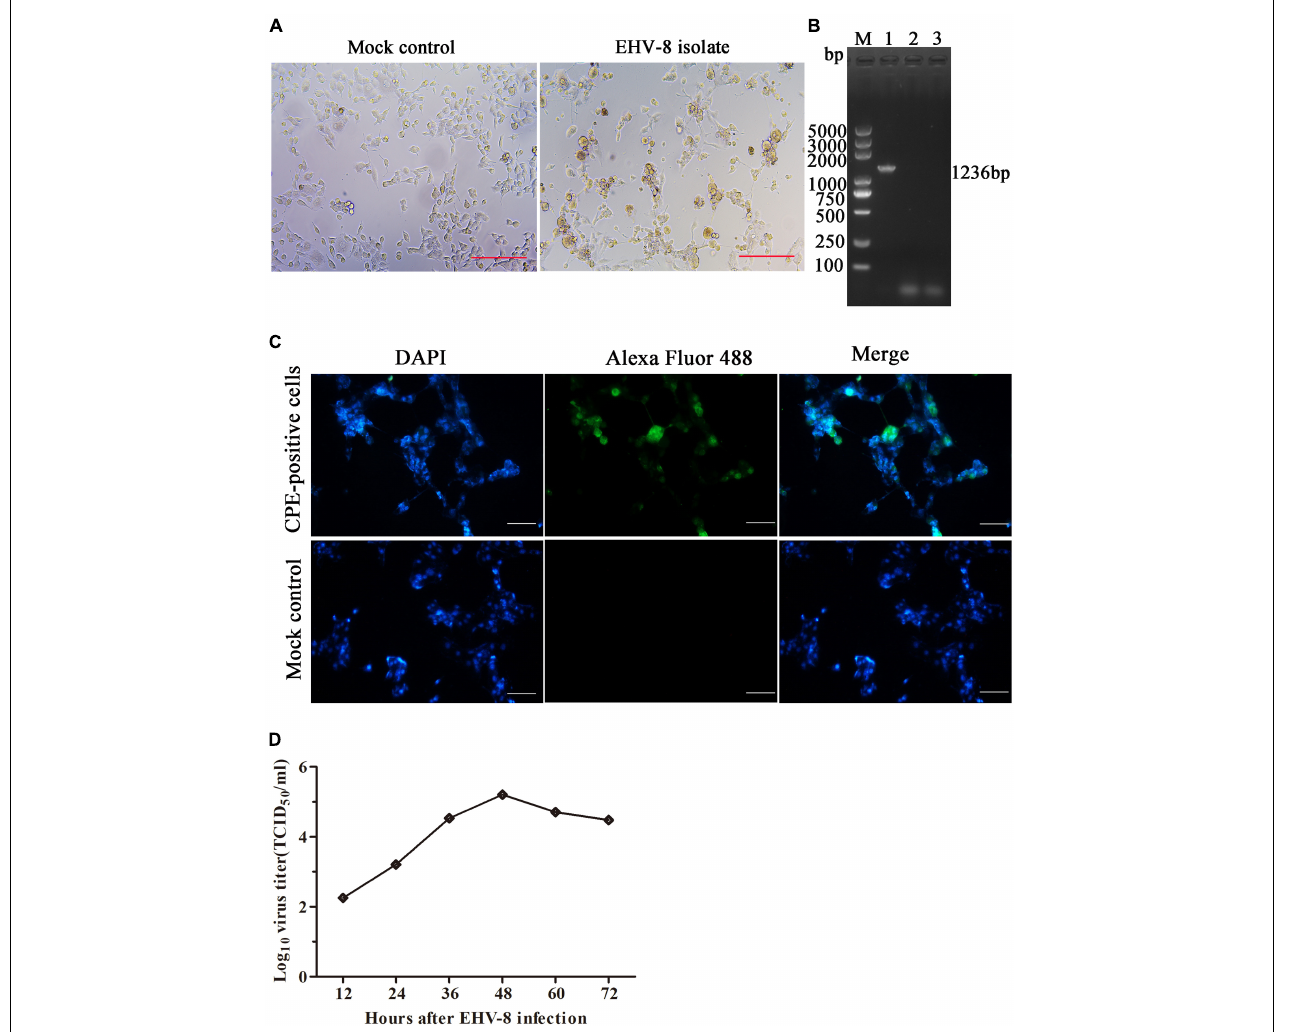
FIGURE 3 | Identification of EHV-8 isolation. The RK-13 cells were inoculated with the supernatant of EHV-8-positive brain samples (right panel) or mock control (left panel). (A) The cytopathogenic effect (CPE) was observed using microscopy at 48 h post-infection. Scale bars, 100 µ m. (B) The ORF70 gene of EHV-8 isolate was determined by PCR detection. The PCR products were analyzed by 1% agarose gel. A marker (lane M) was included on the left, 1 represents CPE-positive cells, 2 represents mock cells, and 3 represents negative control. (C) The EHV-8 isolate was further identified by indirect immunofluorescence assay. The images represent the subcellular locations of EHV-8 proteins using indirect immunofluorescence detection with anti-EHV-8 mouse serum and the corresponding Alexa Fluor 488-conjugated secondary antibodies. Cells were imaged by Leica DMi8. Scale bars, 50 µ m. (D) Growth curve was performed in RK-13 cells to determine the growth characteristics of EHV-8 isolate. Supernatant viruses were harvested at different time intervals in between 12 and 72 hpi, and their titers were determined.